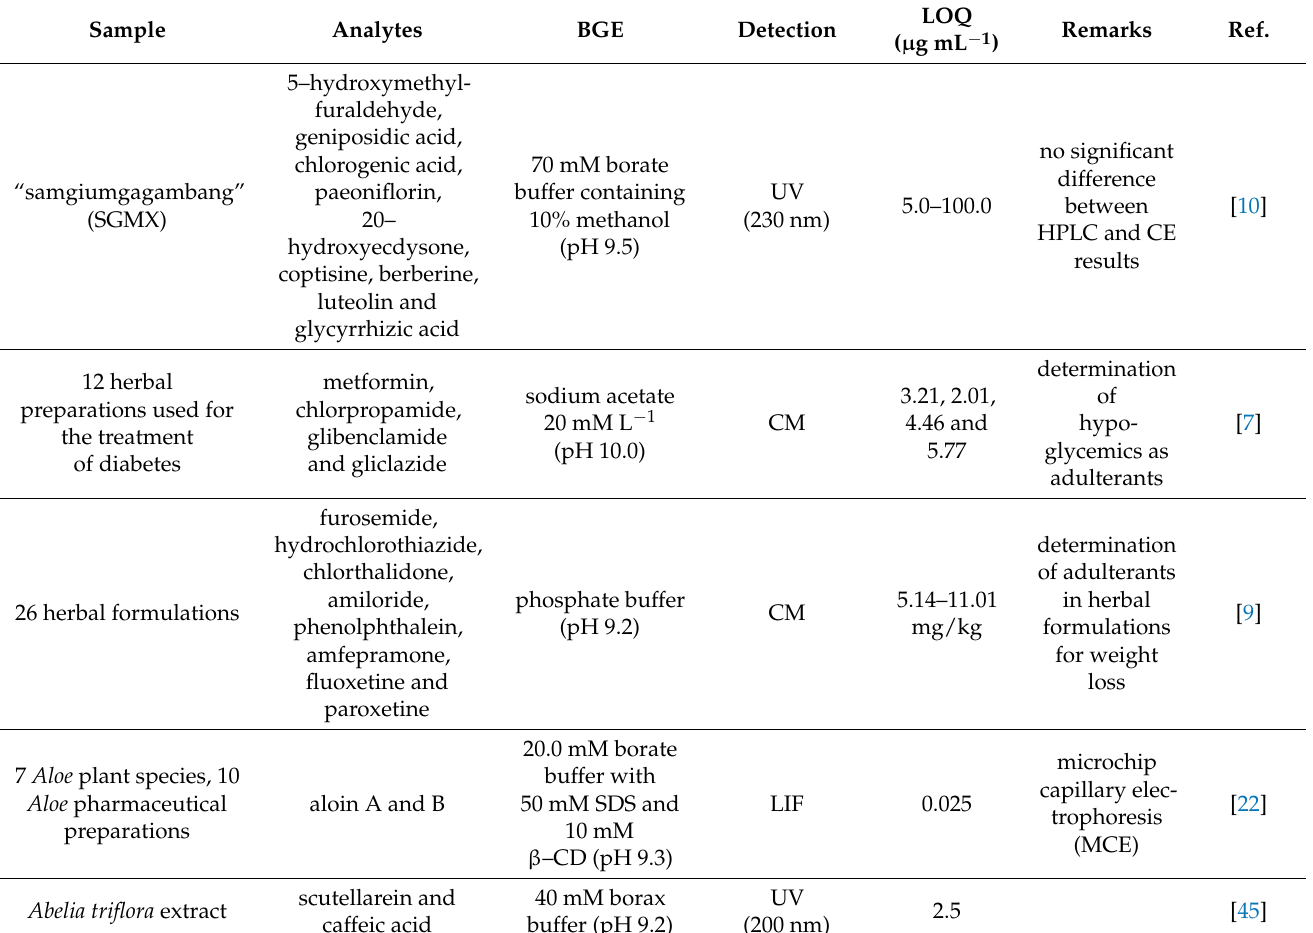
Table 1. Application of capillary zone